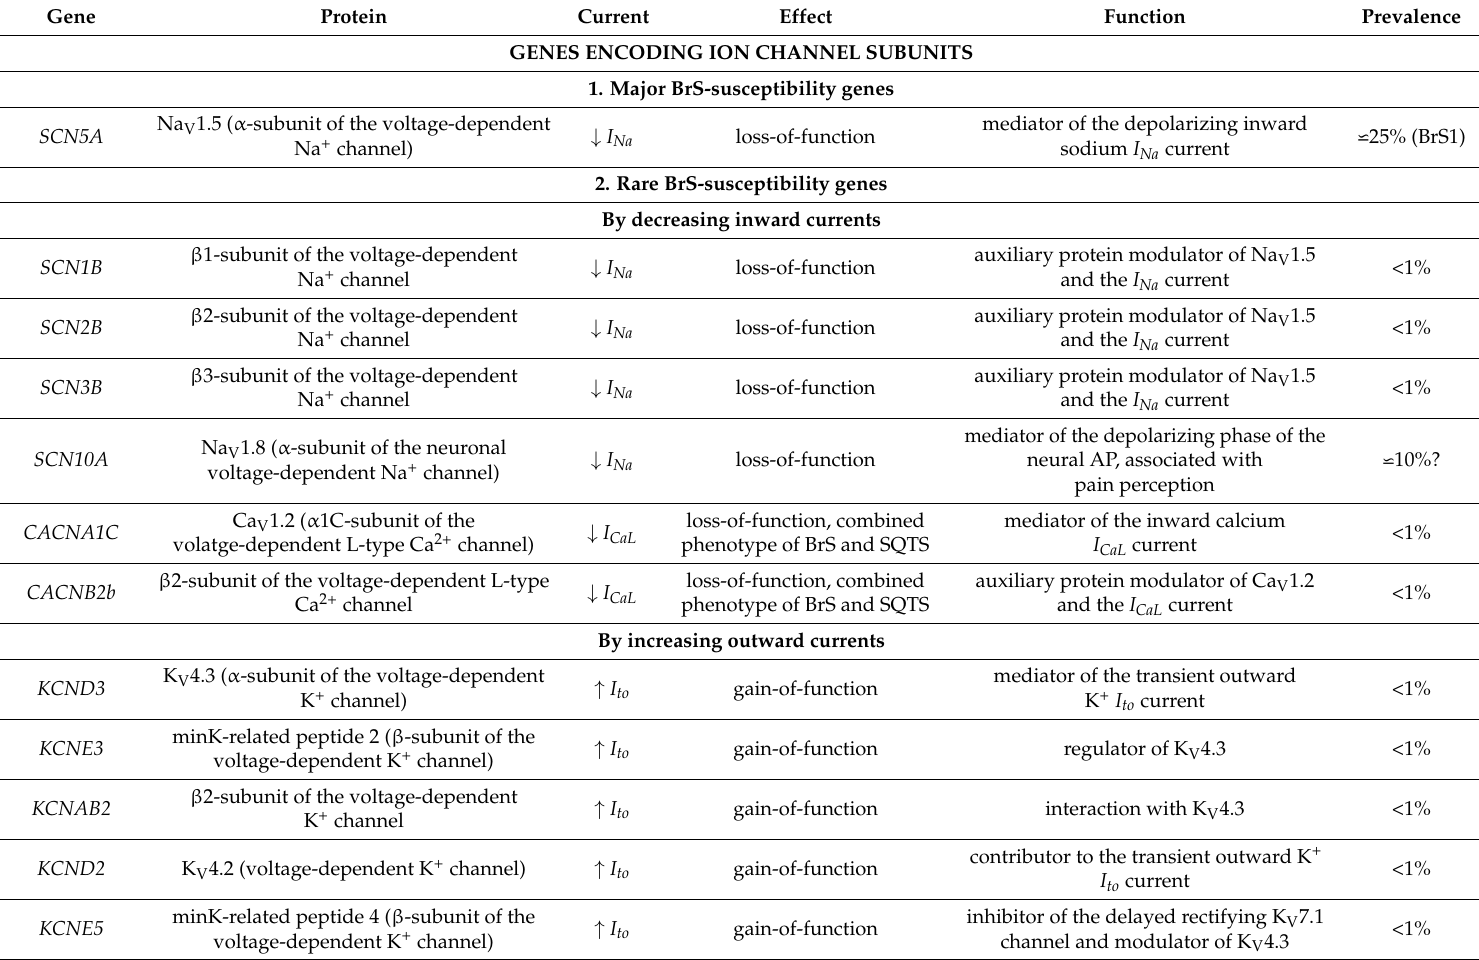
Table 3. Mutations associated with the